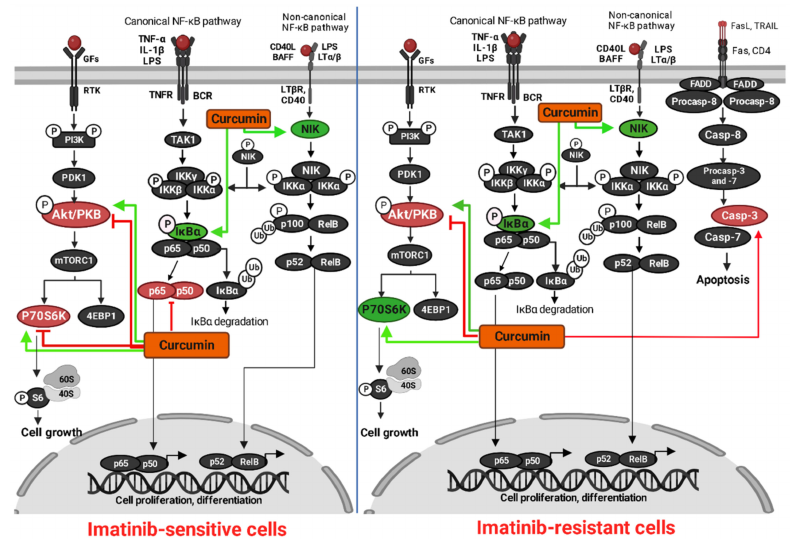
Figure 6. Mechanism of action of curcumin in imatinib-sensitive and imatinib-resistant CML cells evaluated through in vitro (red) and in silico (green) analysis. Shown by Western blot